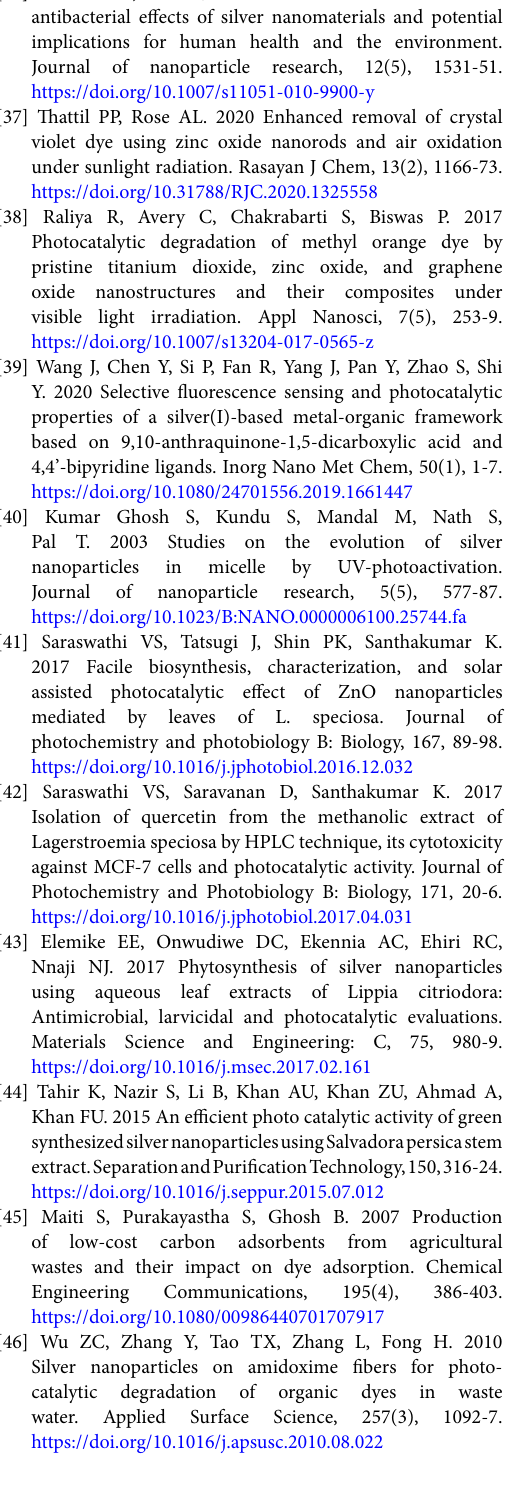
J. Water Environ. Nanotechnol., 7(3): 306-316 Summer